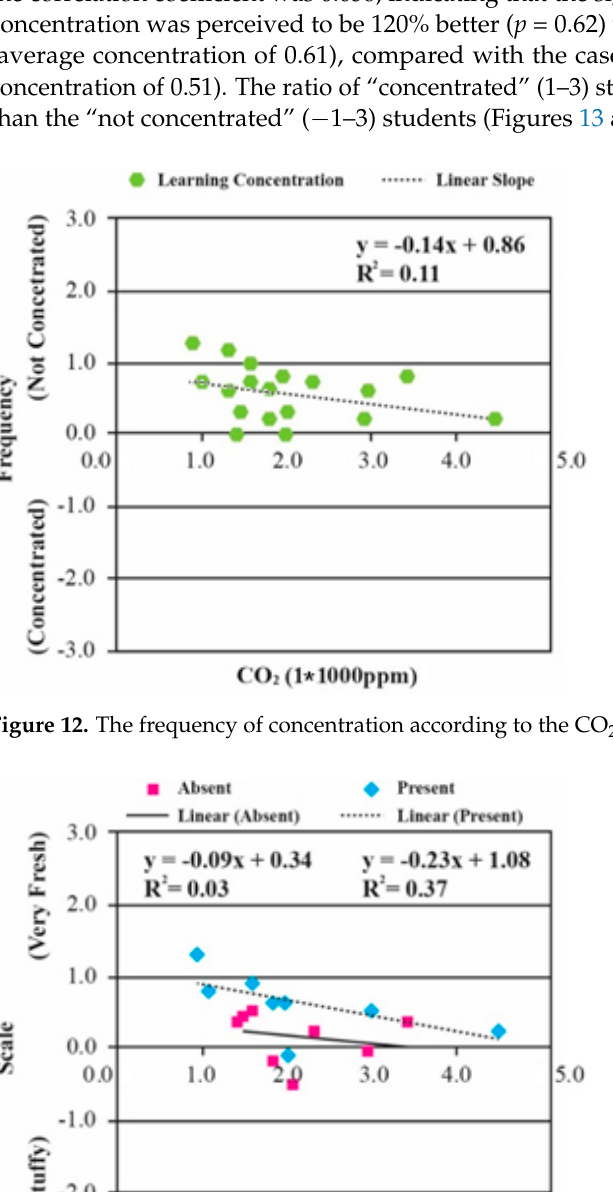
Figure 14. The distribution of learning concentrations according to plant placement.